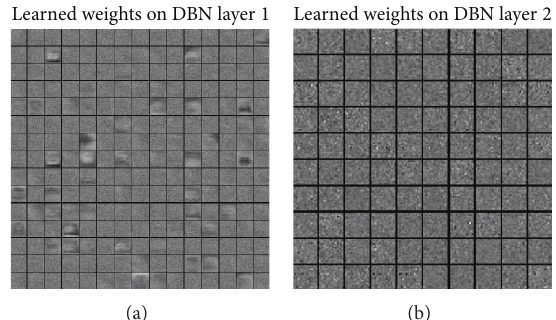
Figure 4: Learned weights of first hidden layer and second hidden layer on 2D-DBN: (a) weights of first hidden layer and (b) weights of second hidden layer.